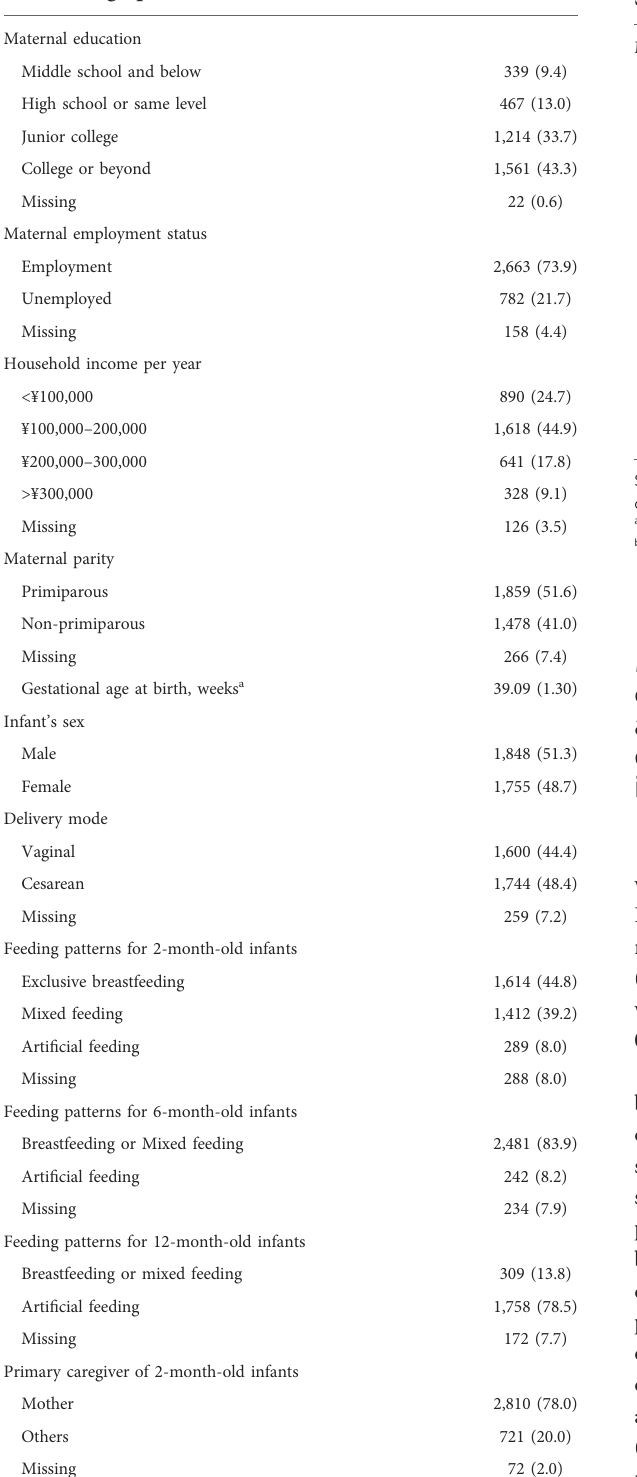
TABLE 1 Characteristics of participants and study variables ( N